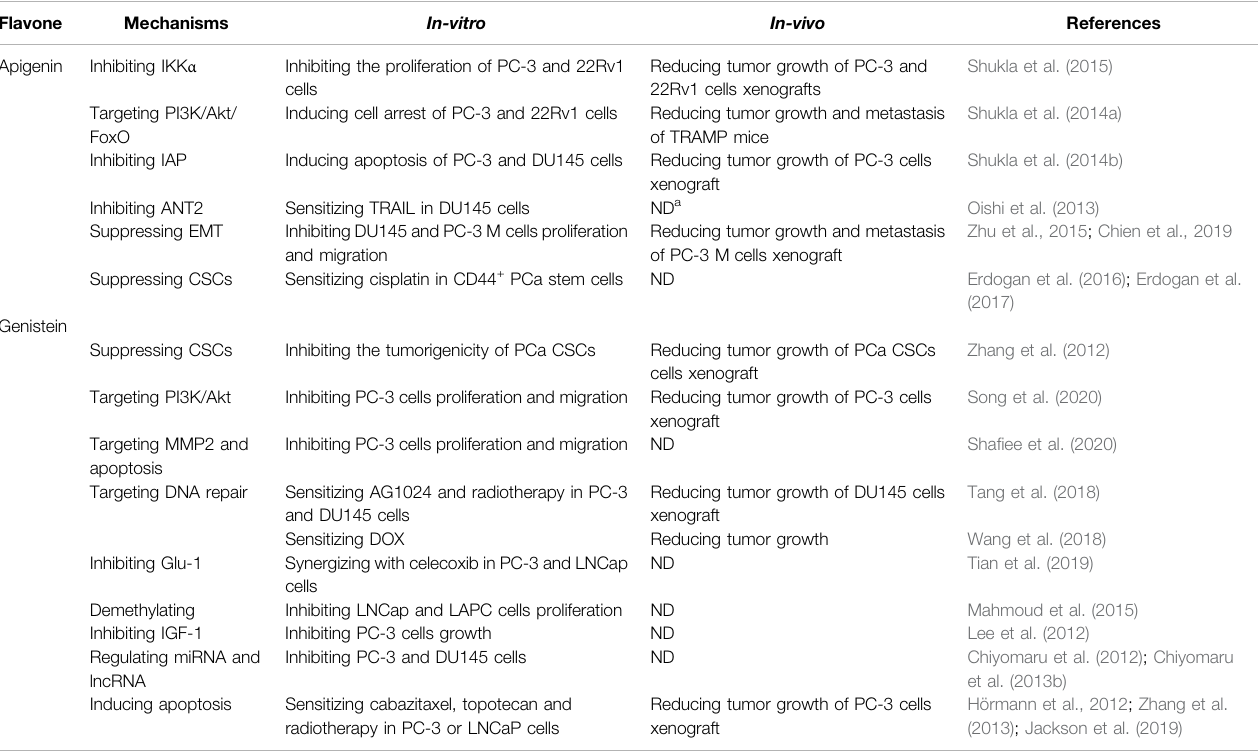
TABLE 1 | Summary (2012 – 2021) of apigenin and genistein in the treatment of PCa.